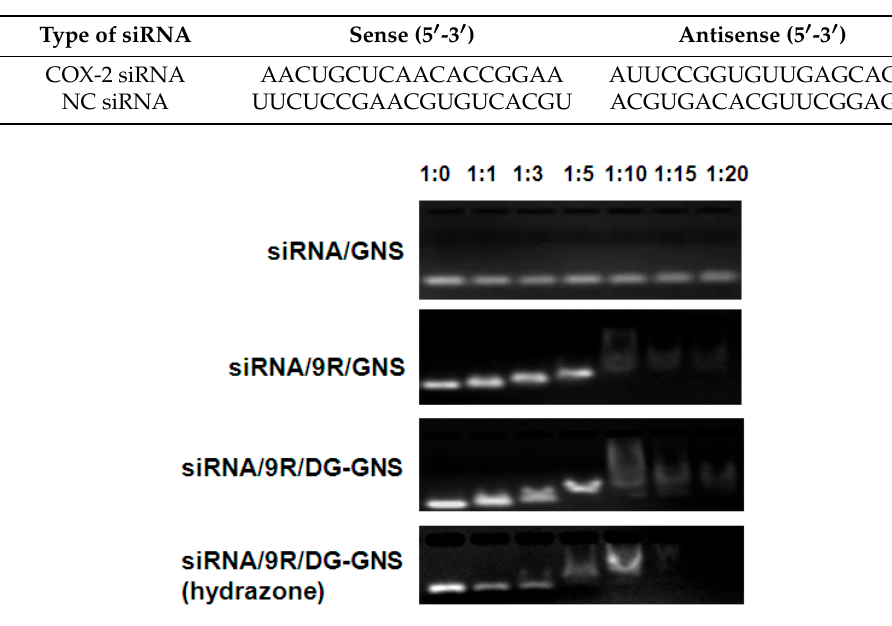
Table 2. The sequences of siRNA.